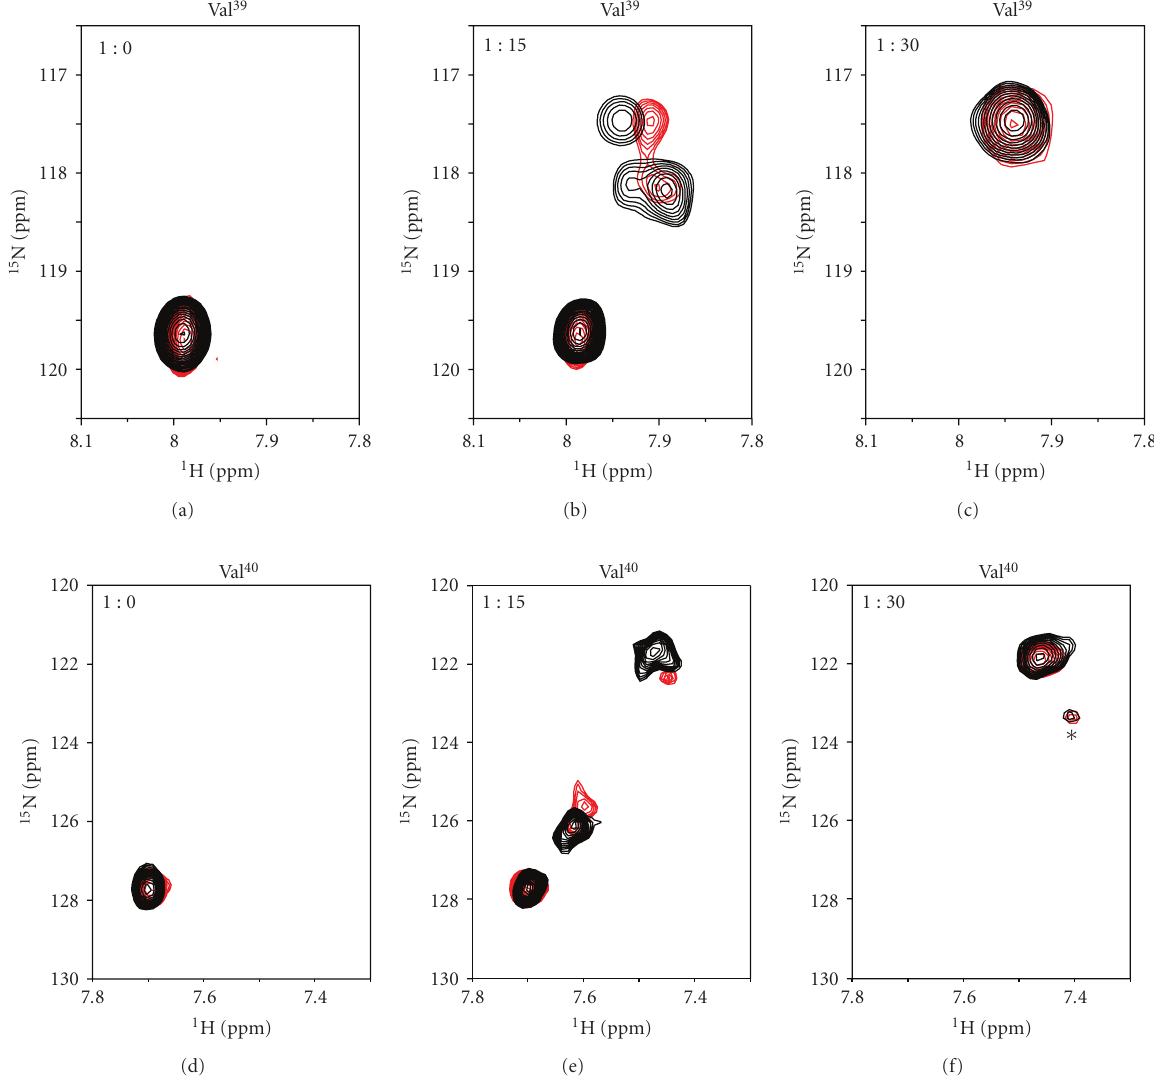
Figure 4: 1 H- 15 N HSQC peak originating from Val 39 (upper) and Val 40 (lower) of A β (1–40) in the presence or absence of GM1 micelles and ThT. Site specifically 15 N-labelled A β (1–40) proteins (0.2mM each) were titrated with GM1 at A β /GM1 molar ratios of 1:0 (a, d), 1:15 (b, e), and 1 :30 (c, f). The spectra measured in the absence (black) and presence (red) of 0.4 mM ThT are overlaid. The peak indicated by asterisk originated from